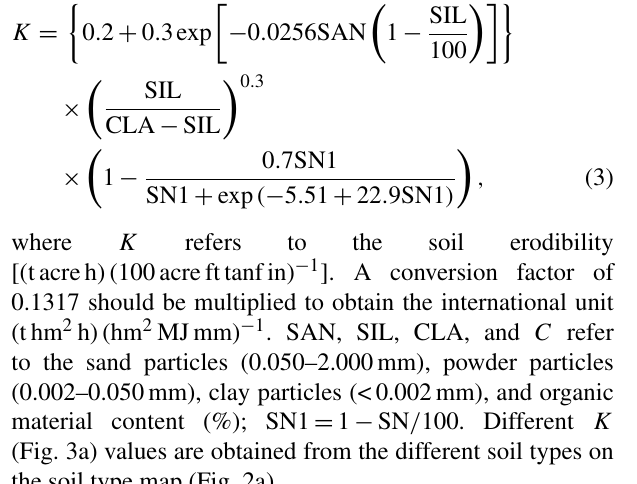
where A [US unit t km − 2 a − 1 ] refers to the amount of soil loss per unit area in time and space and depends on the K and R units. R [MJ mm (hm 2 h a) − 1 ] refers to the rainfall erosiv- ity factor in consideration of the erosion of snowmelt